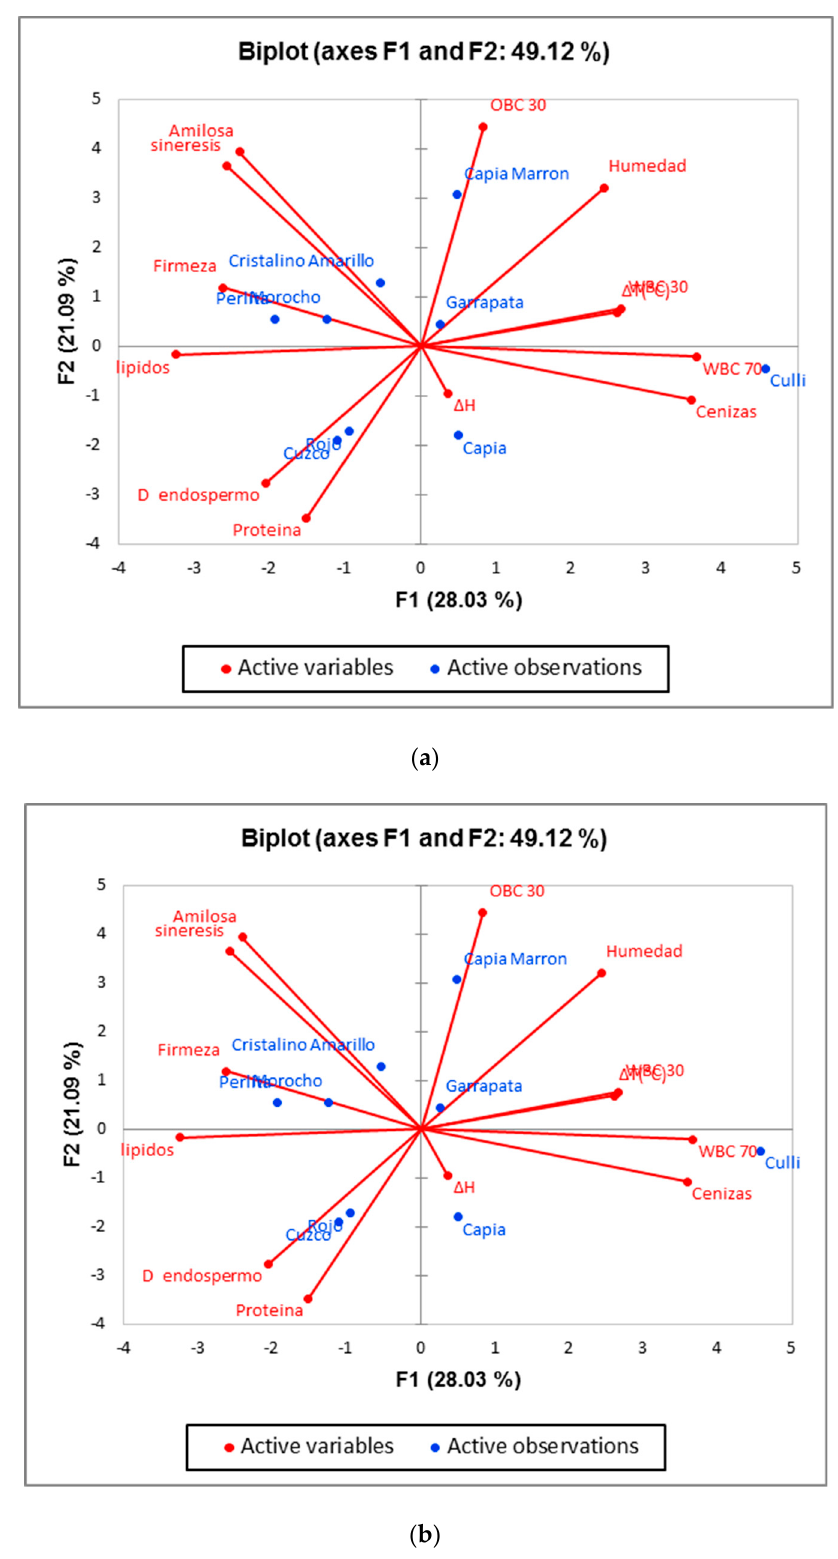
Figure 2. PCA of properties of maize races; ( a ) Chemical composition and techno-functional properties; ( b ) Grouping of maize